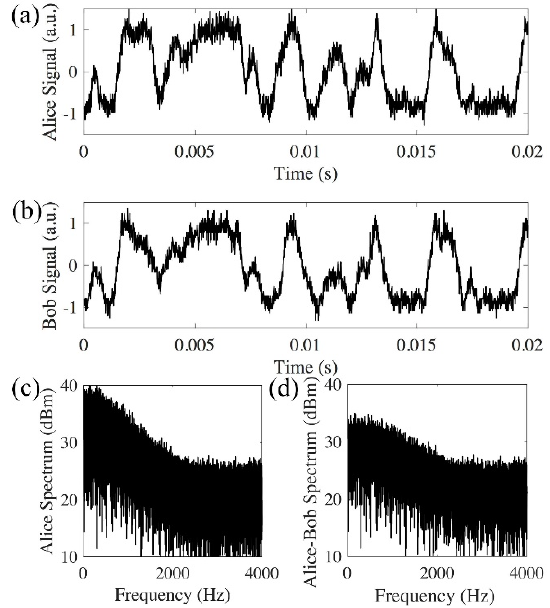
Figure 3. Direct detection of back-to-back signals with 26 km delays from both Alice and Bob. ( a ) Signal received by Alice; ( b ) signal received by Bob; ( c ) Alice’s spectrum; ( d ) differential spectrum between Alice and Bob has a much smaller amplitude than Alice’s spectrum (a.u.: arbitrary unit).